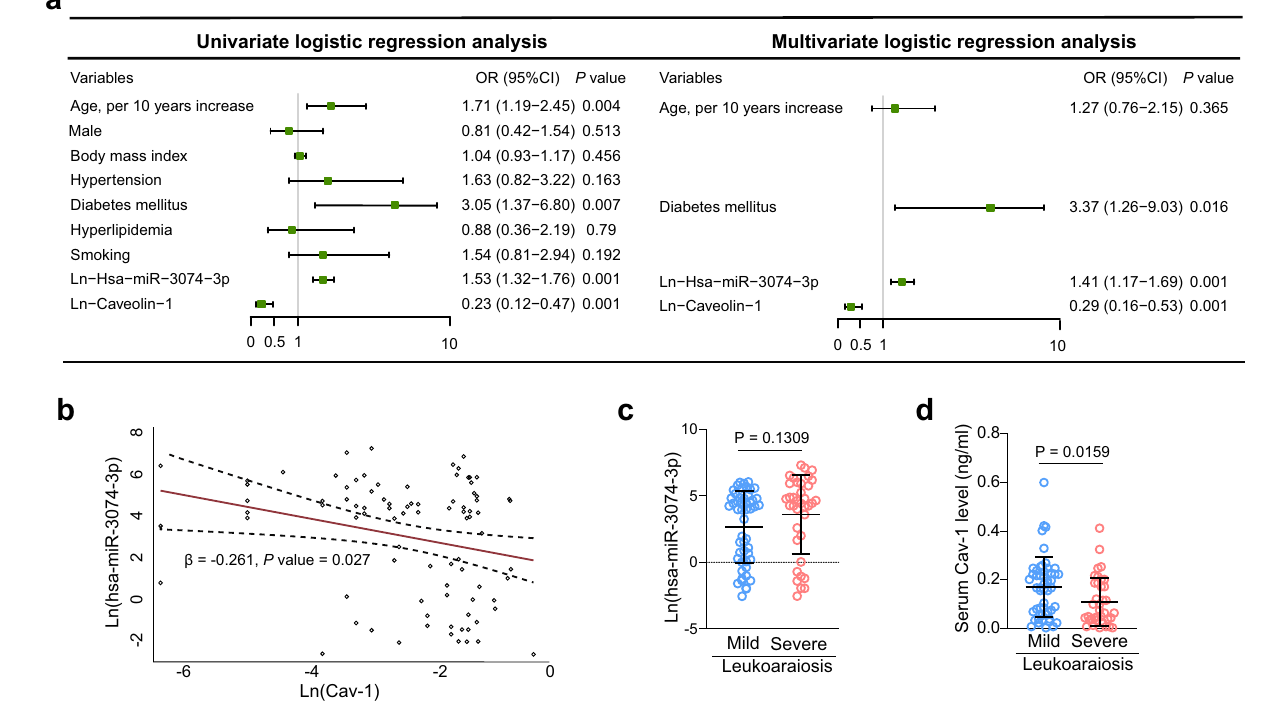
Fig. 7 | Human homolog miR-3074-3p regulating Cav-1 is identi fi ed as a potential signature in leukoaraiosis. a The univariate and multivariate logistic regression analysis with odds ratio (OR) values for leukoaraiosis. In the univariate analysis,theORvalues,95% con fi denceintervals(CIs), and their P -valuesrepresent the odds of leukoaraiosis of the covariates listed in the table. In the multivariate analysis, the OR values, 95% CIs and their P -values represent the odds of leukoar- aiosis after adjusting for the covariates listed in the univariate analysis. The green dots indicate the OR value for the listed variable, and the lines indicate 95% CI. OR totherightofthegreymidline(whereOR=1)indicatehigheroddsofleukoaraiosis